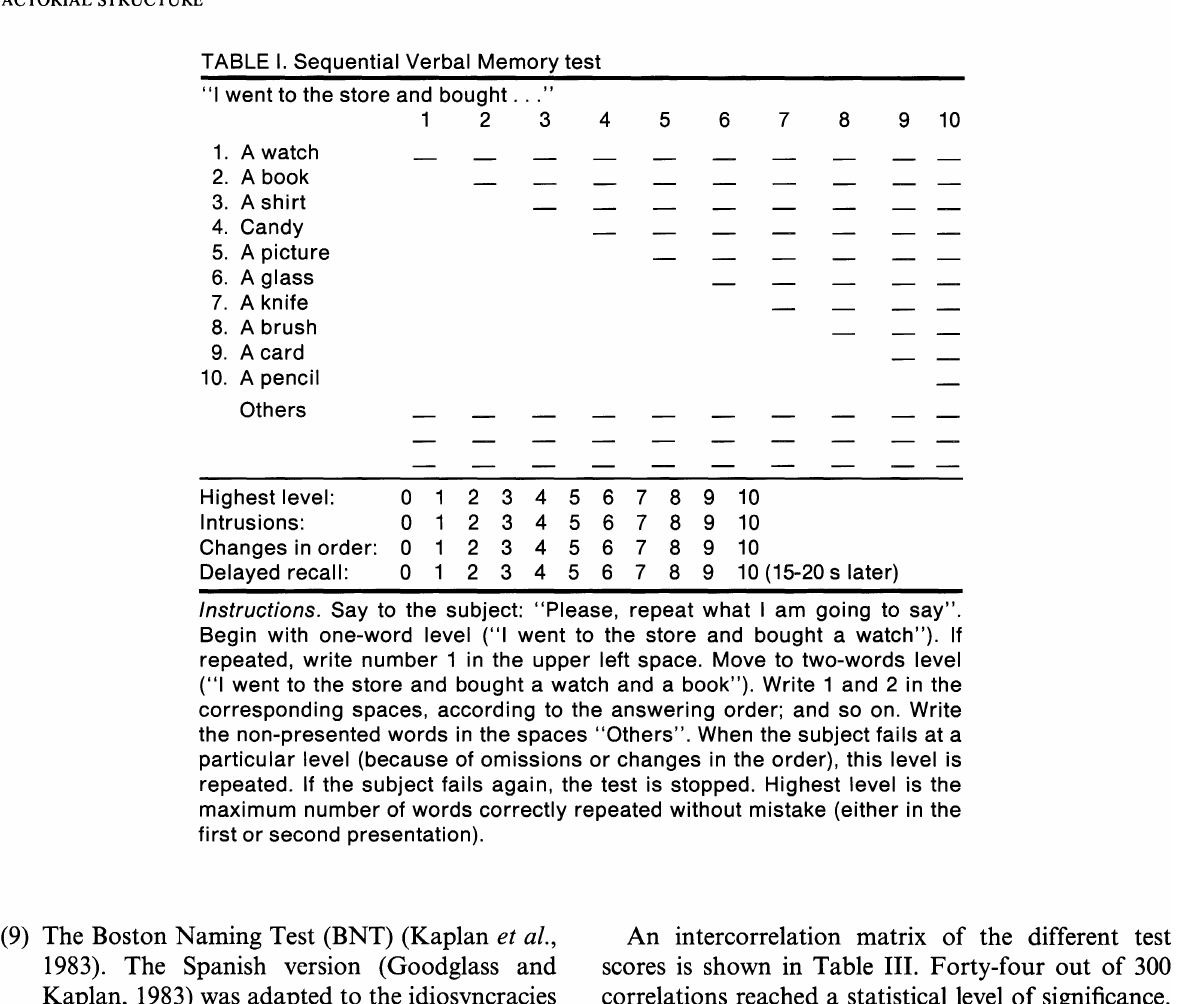
TABLE I. Sequential Verbal Memory